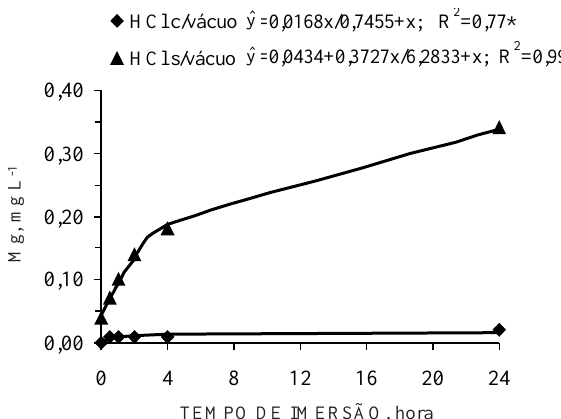
Figura 6. Magnésio na água de imersão das cápsulas tratadas com HCl 0,1 mol L -1 mais 45 min em água destilada e deionizada, considerando o tempo de